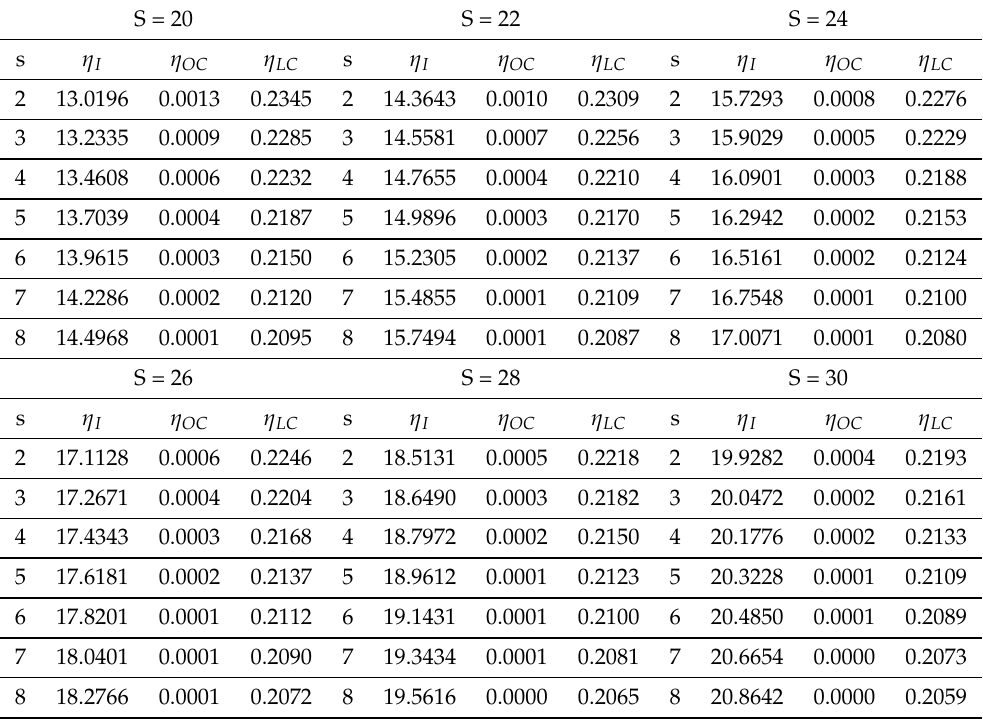
Table 5. Ramification of some